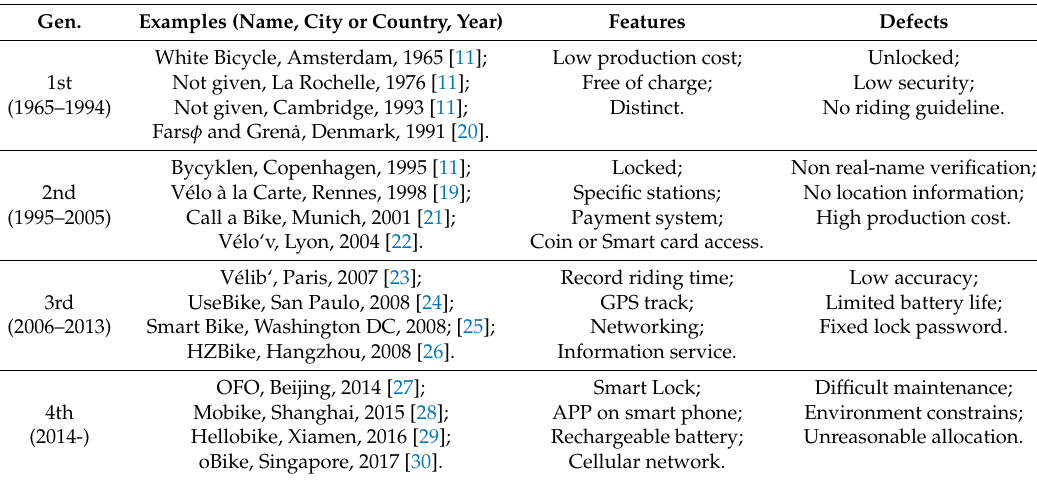
Table 2. Progress of shared